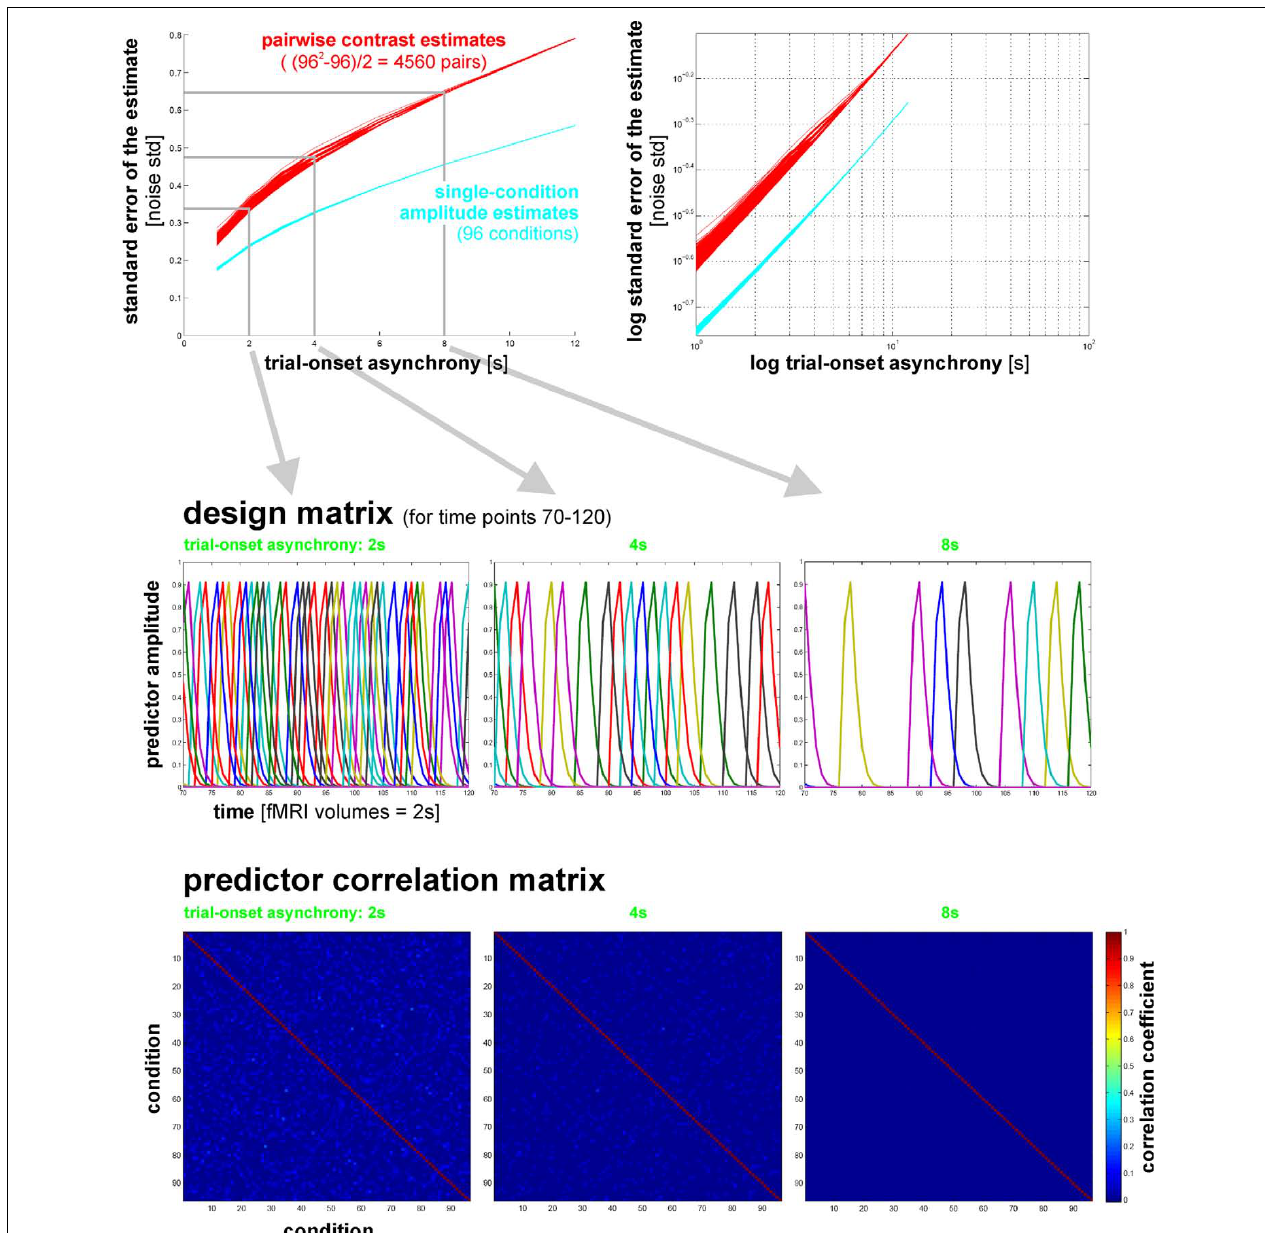
FIGURE 11 | Design effi ciency as a function of trial-onset asynchrony for a 96-condition fMRI design . This fi gure shows simulation results exploring how statistical effi ciency depends on the trial-onset asynchrony (TOA) under linear- systems assumptions for a 96-condition design with one hemodynamic- response predictor per condition and a random sequence of experimental events (including 25% null events for baseline estimation). We assume that about 50 min of fMRI data are to be collected in a single subject. The simulation suggests a simple conclusion: The more closely the trials are spaced in time, the higher the effi ciency will be (top panels) for single-conditions (cyan) and pairwise condition contrasts (red). Doubling the number of trials packed into the same 50- min period, then, would improve effi ciency about as much as performing the whole experiment twice: decreasing the standard errors of the estimates roughly by a factor of sqrt(2). In other words, the standard errors are proportional to sqrt(TOA). (Why does not the greater response overlap decrease effi